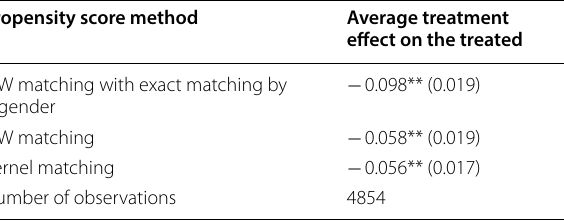
Table 4 Average effect of working in a changing firm on the probability of being an internal